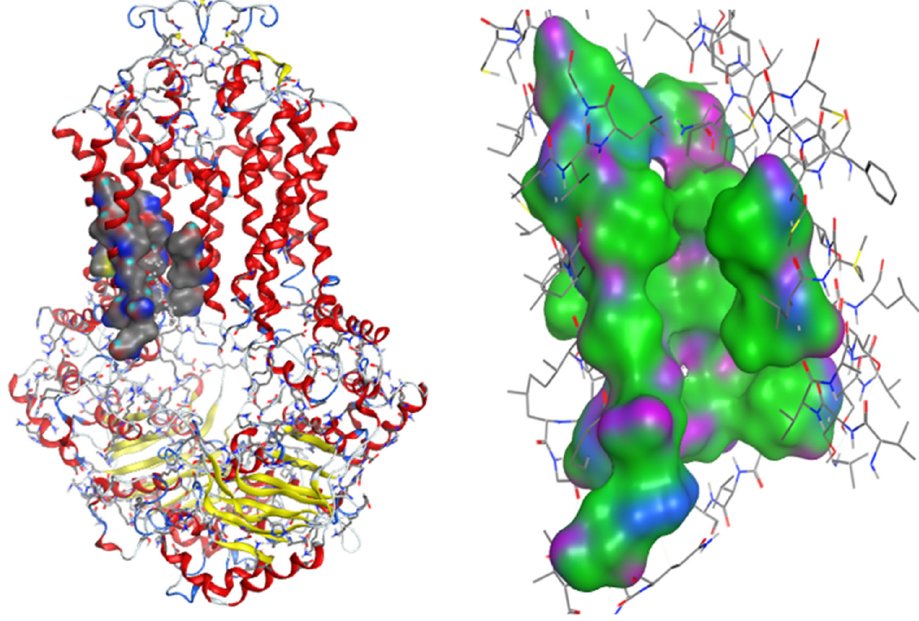
Figure 8. The binding site of the inhibitor on ABCG2. The green area represents the hydrophobic zone, the blue area represents the slightly polarized zone, the pink area represents the hydrophilic zone.